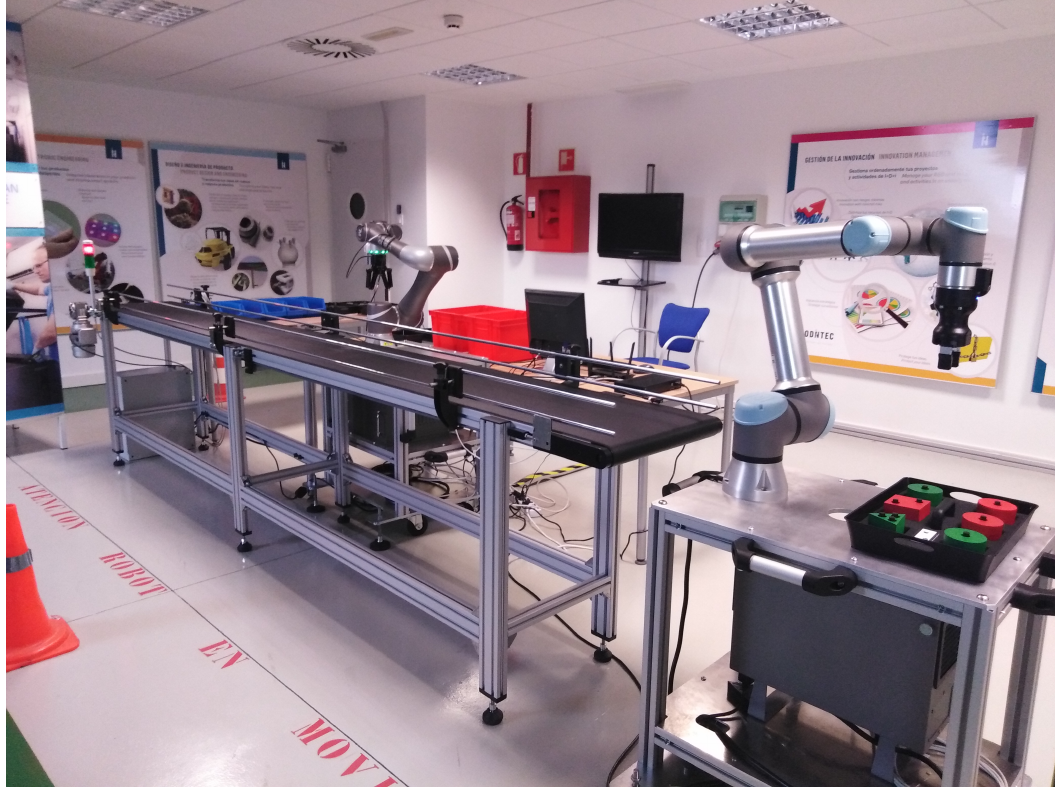
Figure 10. General view of the real scenario.